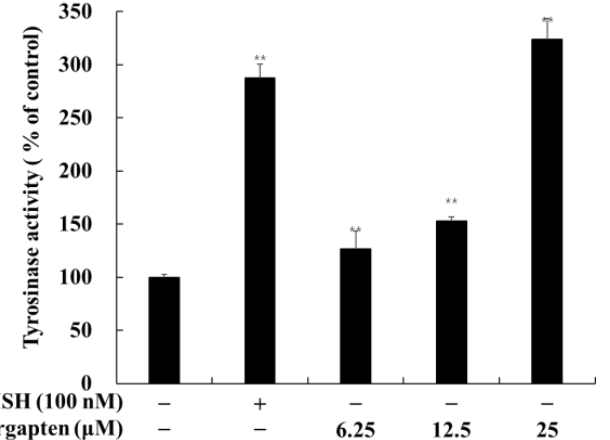
Figure 4. Effects of bergapten on tyrosinase activity in B16F10 melanoma cells. The cells were treated with bergapten (6.25, 12.5, and 25 μM) and α - MSH (100 nM) for 72 h. α -MSH was used as a positive control. The results are presented as the mean ± SD of three independent experiments. ** p < 0.01 vs. the untreated group.